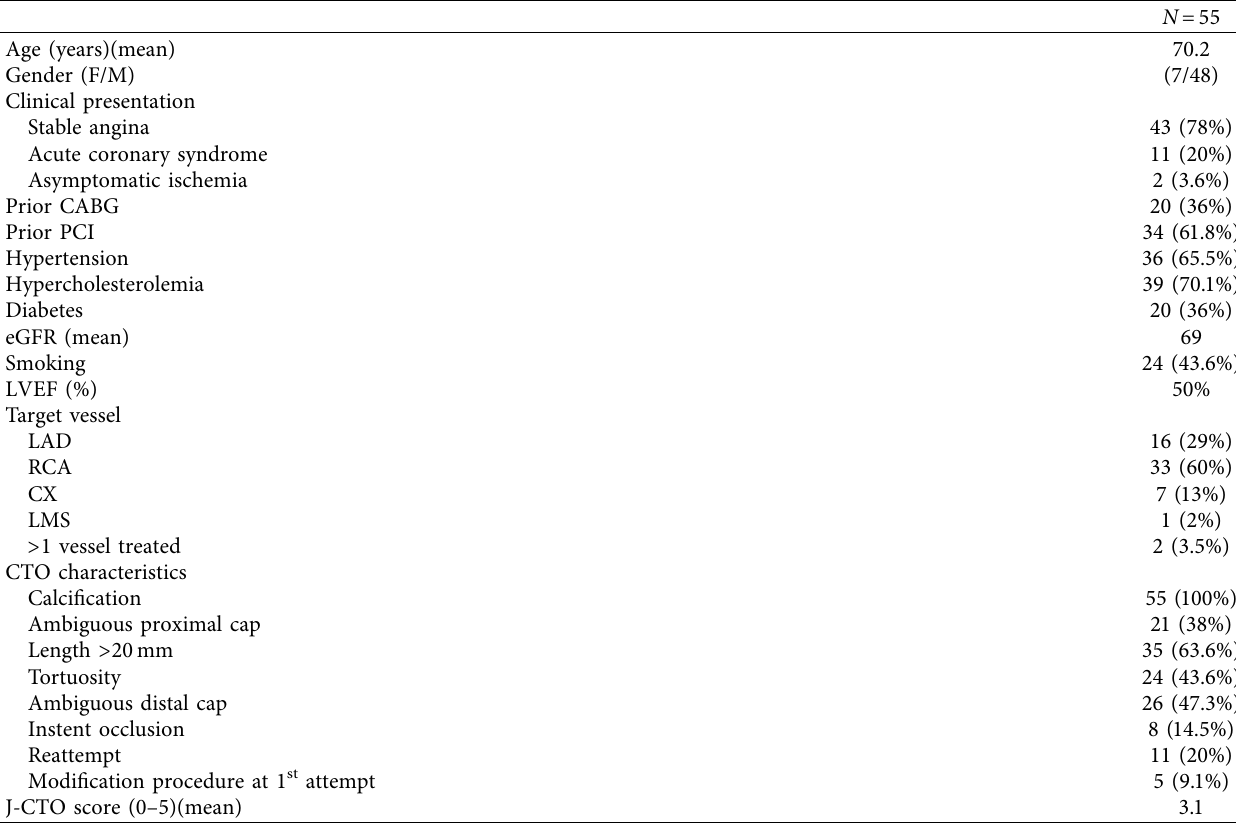
Figure 1: Calcium morphologies (concentric: smooth surfaced with reverberations consistent with thin calcium; eccentric: irregular surface with no reverberation consistent with thick calcium; nodule: luminal protrusion with irregular leading edge; pseudonodule: subintimal space expansion with displacement of calcified plaque and lumen). Table 1: Patient demographics and CTO